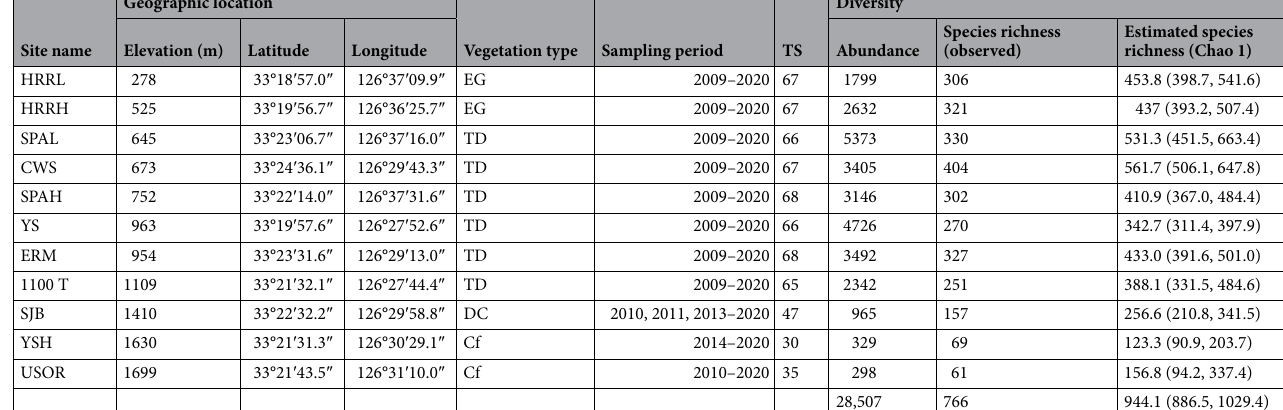
Table 1. Information of the geographic location, elevation (m), vegetation type, sampling period, number of samplings, the number of individuals (abundance), and species (species richness, observed and Chao 1 estimated with lower and upper 95% confidence interval) of moths collected from 2009 to 2020 in Mount. Hallasan National Park (HNP), South Korea. Vegetation: EG. Evergreen, TD, Temperate deciduous, DC, Mixed deciduous and coniferous, Cf, Coniferous. TS (Total sampling counts) differed because of the survey period and sampling failure due to harsh weather conditions or mechanical